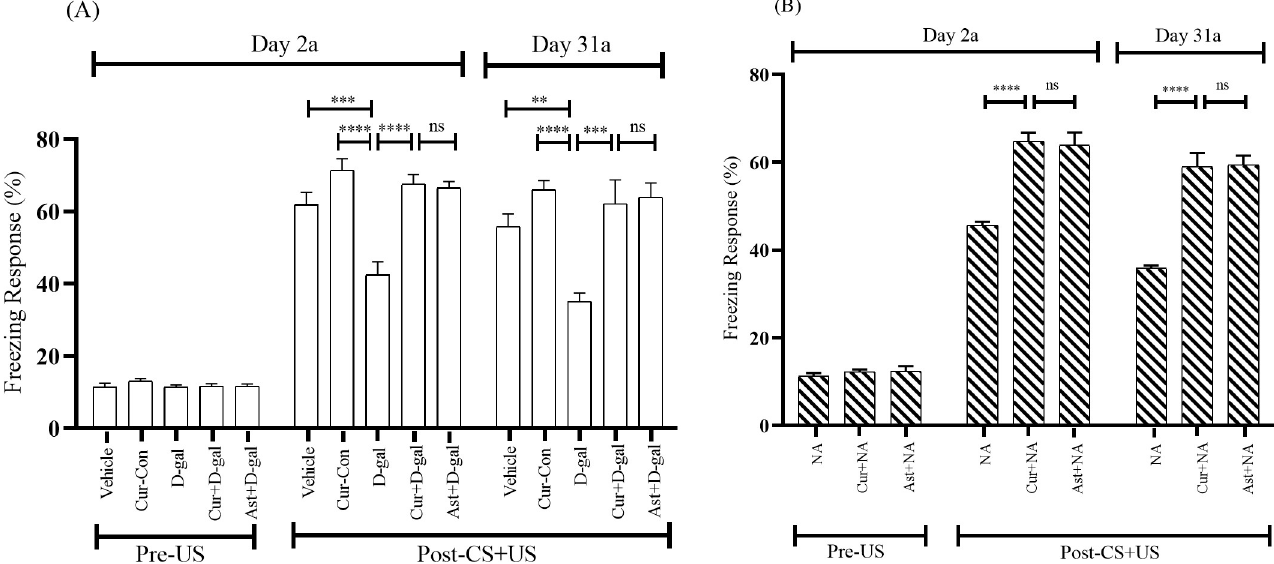
Fig 3. Effect of curcumin on the conditioning fear memory of (A) D-gal and (B) NA mice group. The memory was assessed by analyzing the FR. The FR was expressed in percentage (%). Data was presented as mean ± SEM, n = 8 each group; �� p < 0.01, ��� p < 0.001, ���� p < 0.0001, ns = not significant.